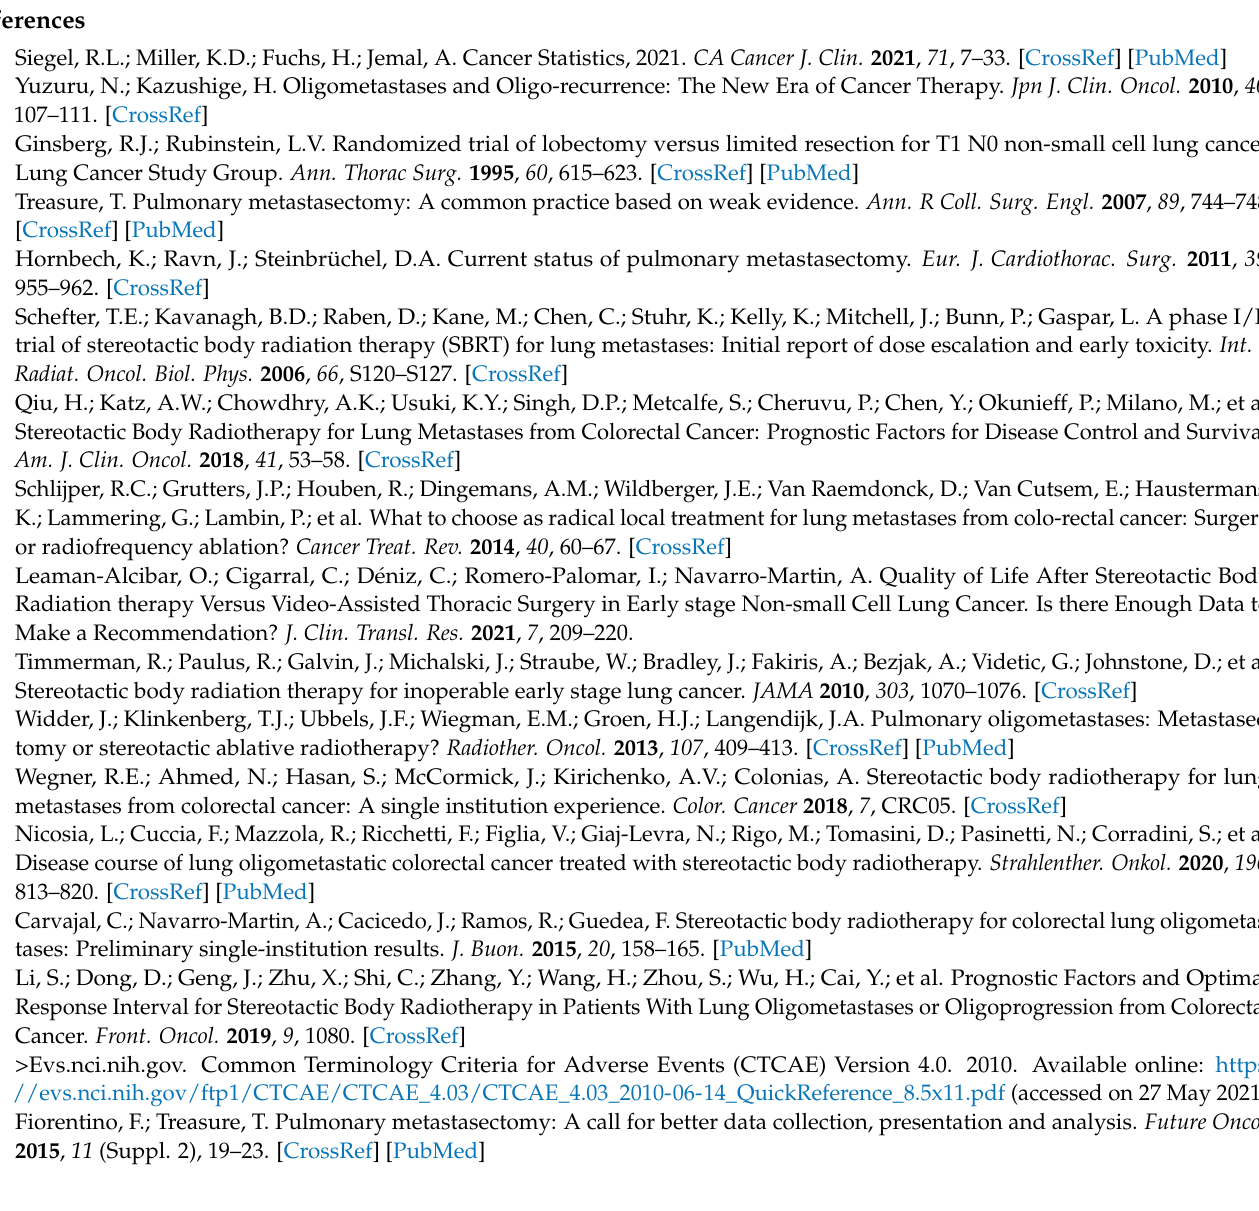
Figure A5. Kaplan – Meier curve of overall survival according to treatment received. p = 0.628. Figure A5. Kaplan–Meier curve of overall survival according to treatment received. p =